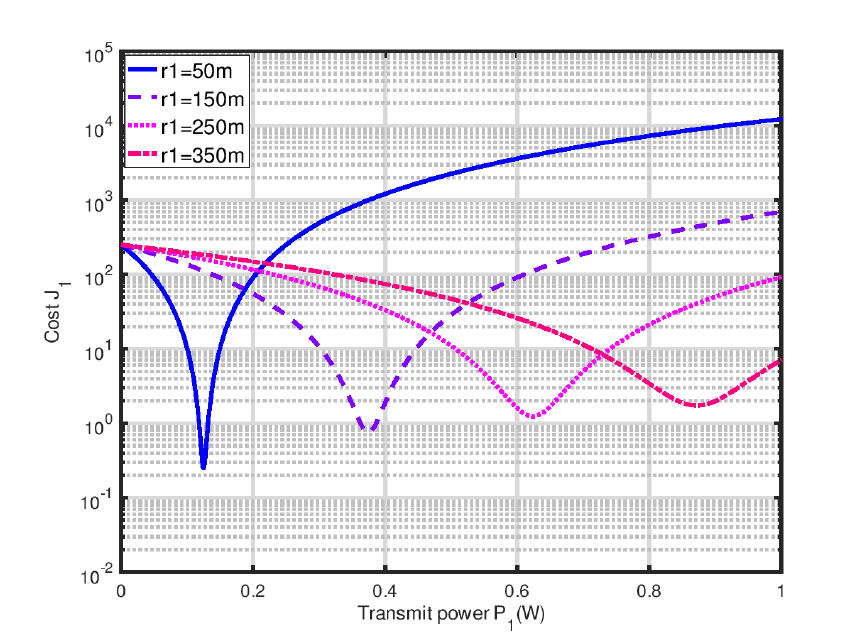
Figure 4. Nash equilibrium depends on the distance between the D2D transmitter–receiver pair.